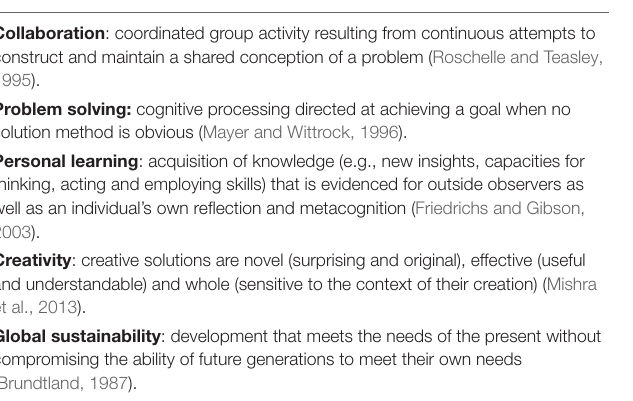
TABLE 1 | Construct definitions of team learning attributes in Balance of the Planet. Collaboration : coordinated group activity resulting from continuous attempts to construct and maintain a shared conception of a problem (Roschelle and Teasley, 1995).